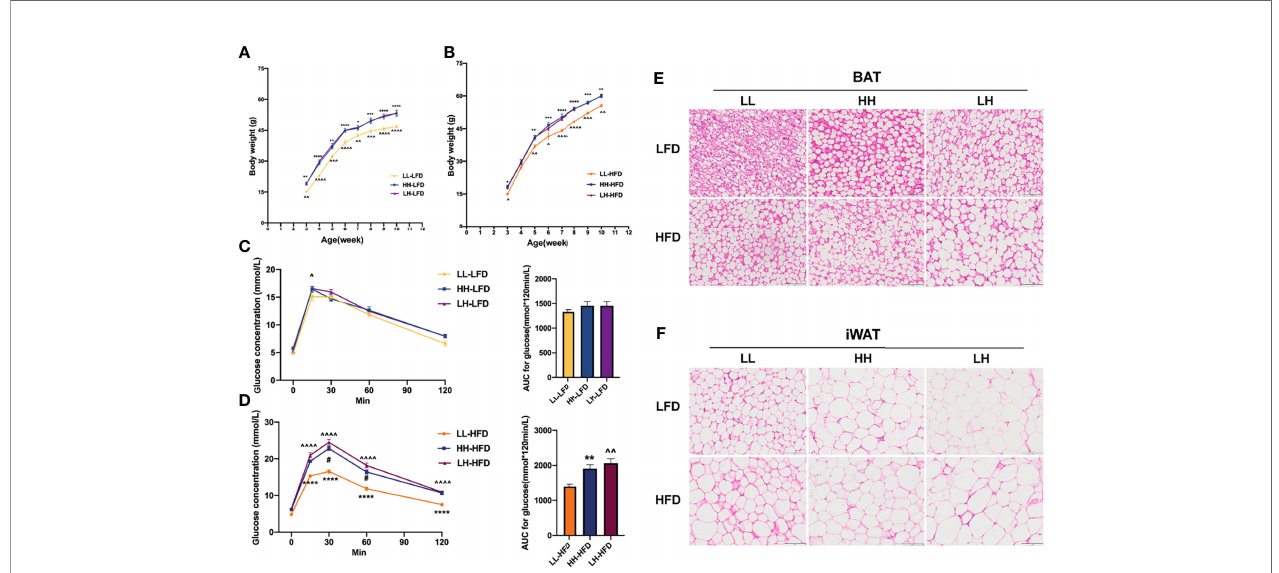
FIGURE 3 | Offspring of LH were most prone to developing obesity and metabolic disorder when challenged with HFD post-weaning. Body Weight changes of mice from the LL, HH, and LH group fed post weaning LFD (A) (n = 10, from 5 litters) or HFD (B) (n =10, from 5 litters) until they were 10 weeks old. GTT and AUC quanti fi cation of 10-week-old LL, HH and LH mice fed LFD (C) or HFD (D) (n = 5, from 5 litters). Hematoxylin and eosin – stained BAT (E) and iWAT (F) sections of 10-week-old LL, HH and LH mice fed LFD or HFD (n = 3, from 3 litters). Data are expressed as the mean ± SEM. * p < 0.05, ** p < 0.01, *** p < 0.001, **** p <